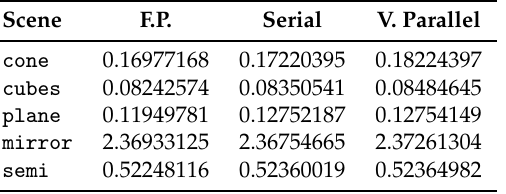
Table 10. Mean absolute differences from ground truth. Disparity ranges for each scene are shown in Table 4.